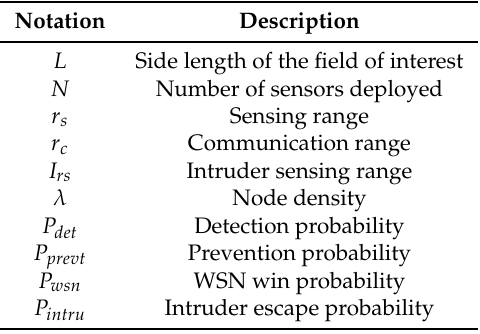
Table 1. Notation